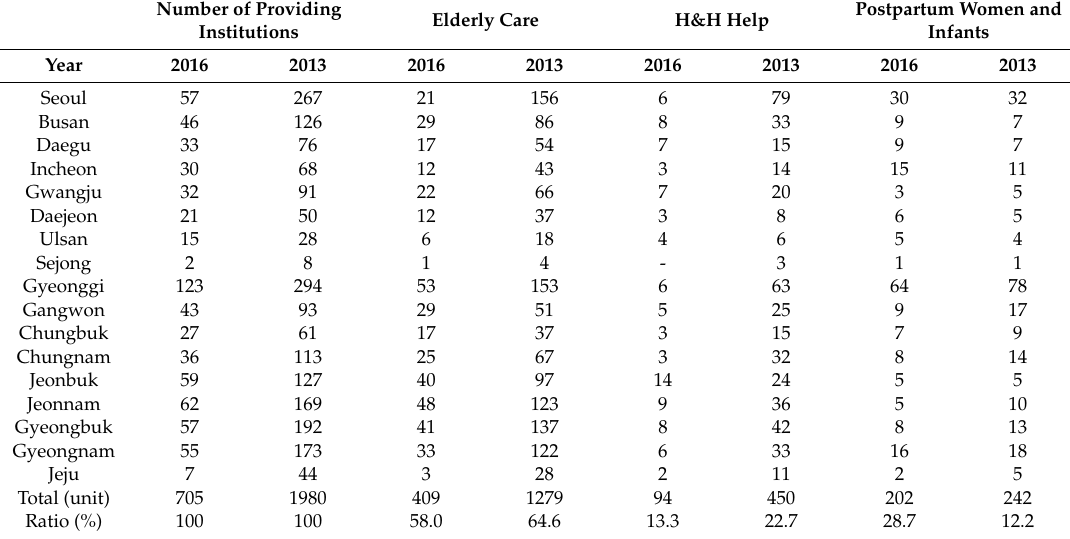
Table 1. Distribution status of target providing institutions of social service evaluation (unit: piece (%)). Number of Providing Elderly Care H&H Help Institutions